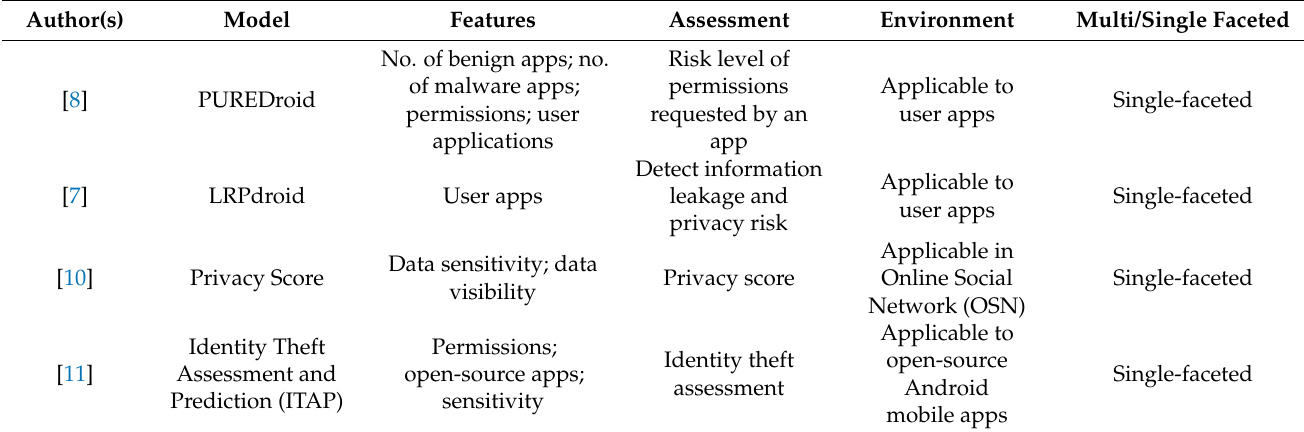
Table 5. Existing works and their